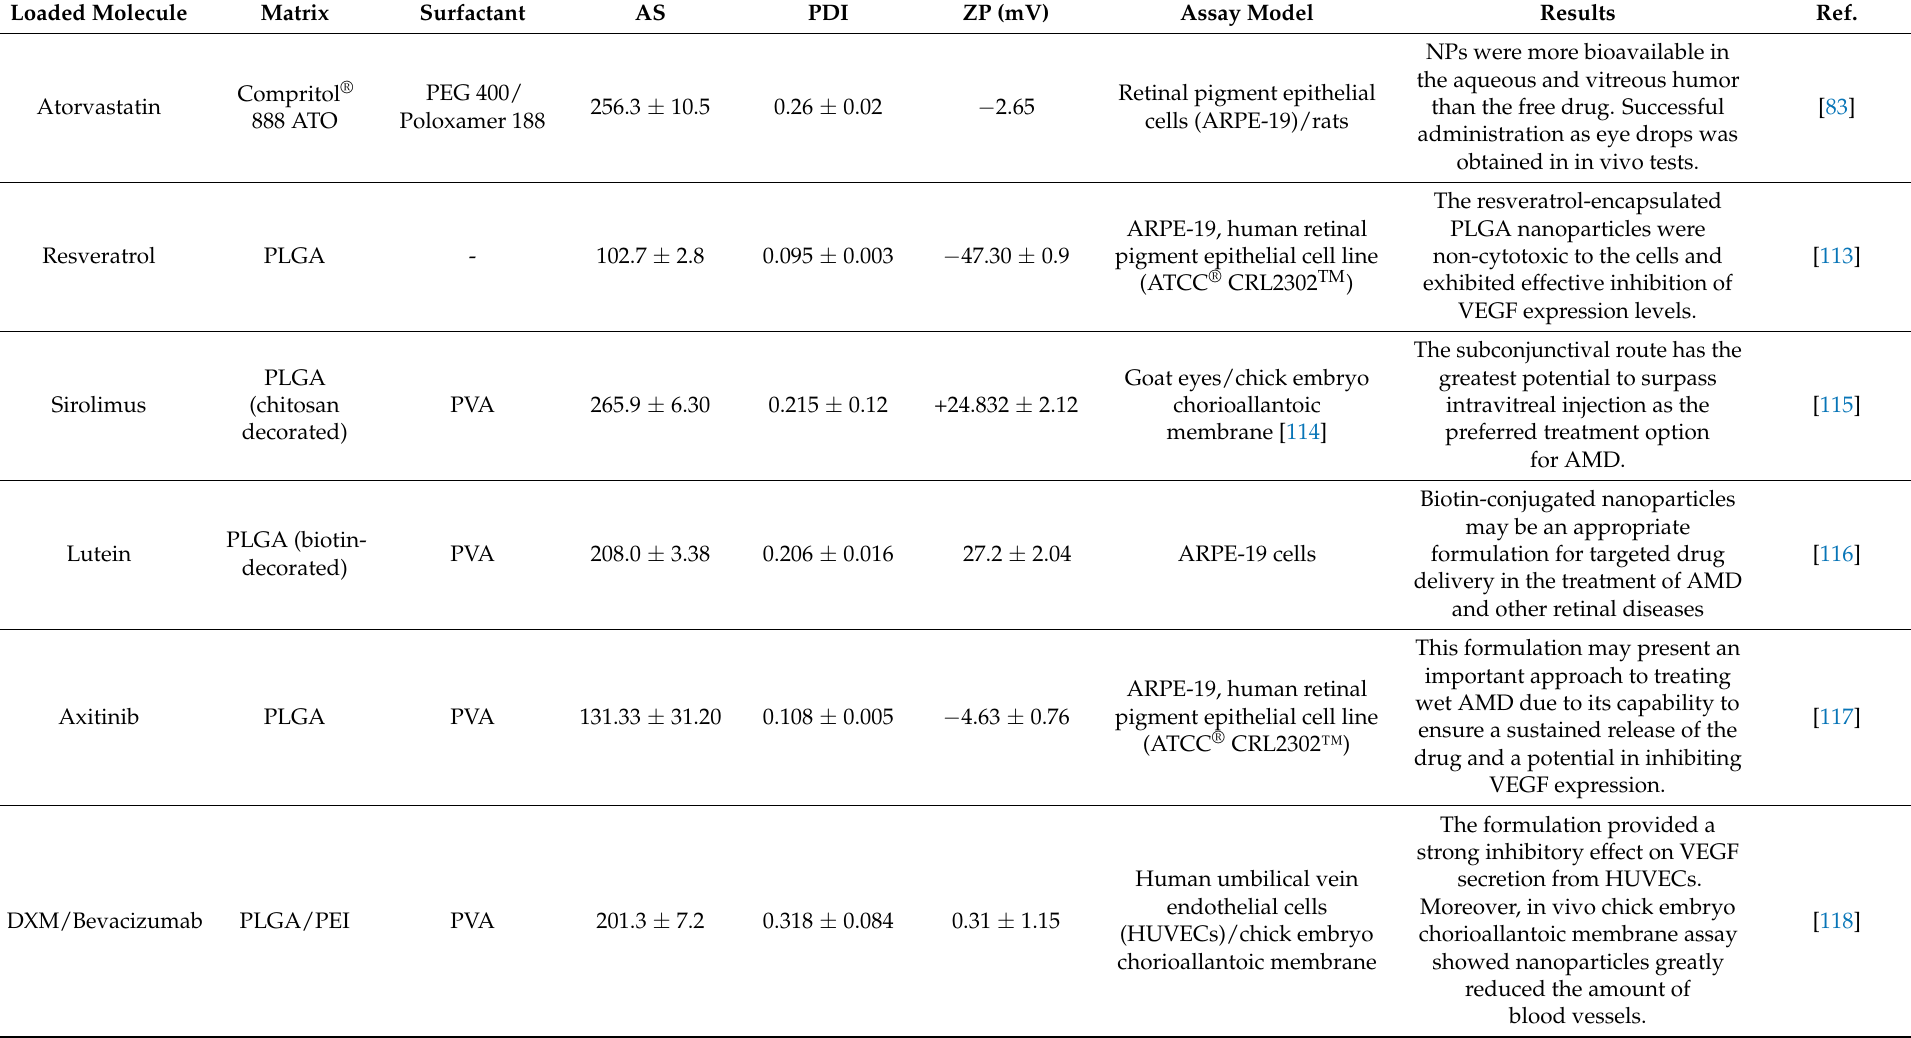
Table 5. Selected preclinical studies based on novel drug-loaded biodegradable nanoparticles for the treatment of AMD. Loaded